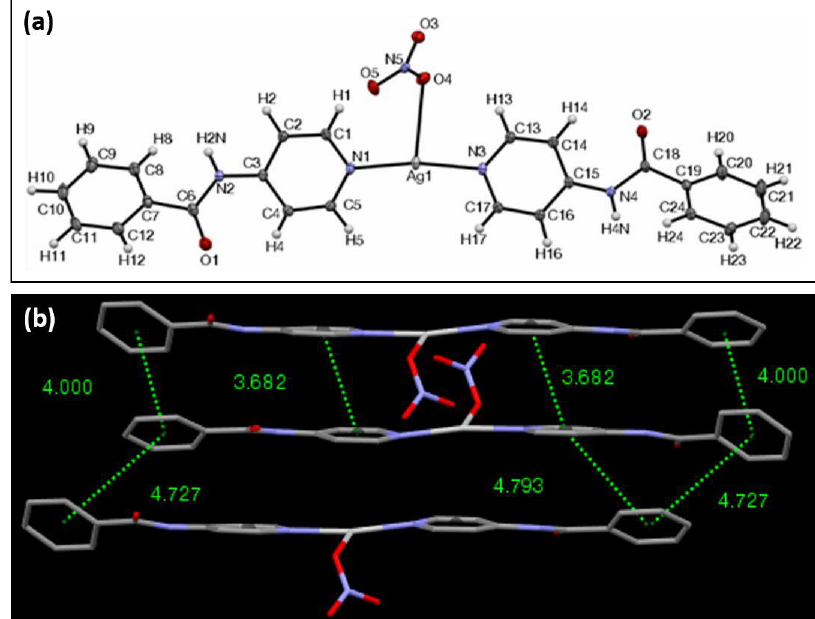
Figure 2. ( a ) ORTEP view of complex 1 with ellipsoids drawn at 30% probability; ( b ) View of the π–π interaction network of complex 1 , showing that the aromatic centroid-to-centroid distances are less than 4.80 Å .